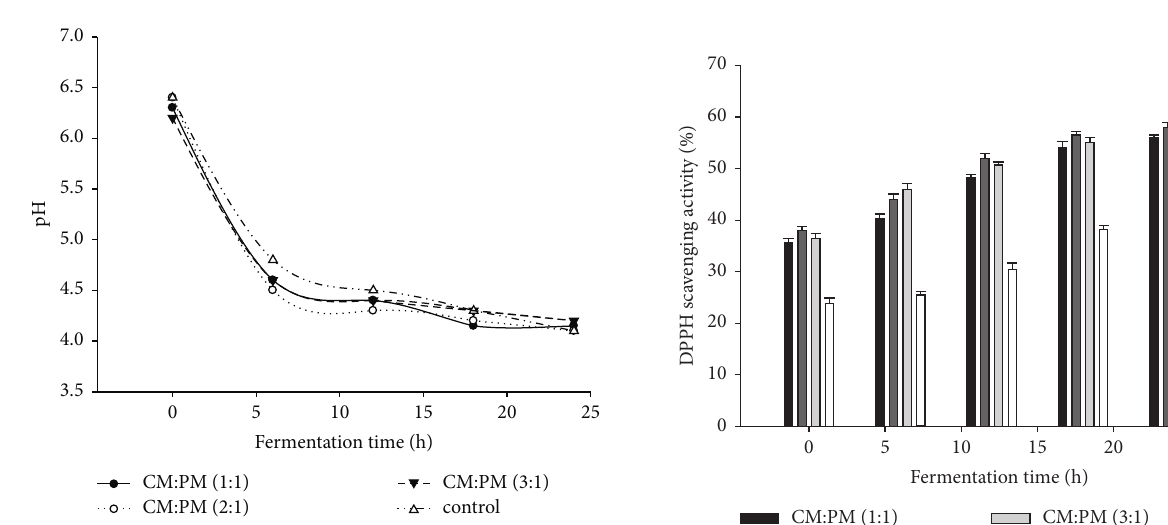
Figure 4: Lacticaseibacillus rhamnosus Yoba viable cell counts of four samples at different fermentation times. All the values are expressed as mean ± SD ( n � 3). CM, cowpea milk; PM, peanut milk.